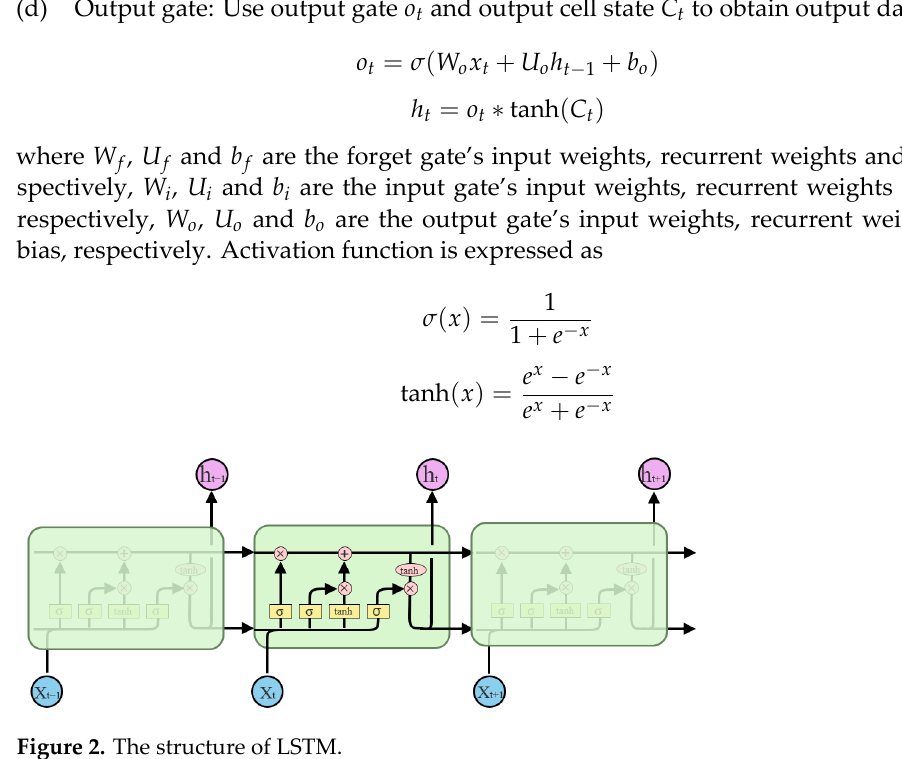
Figure 2. The structure of